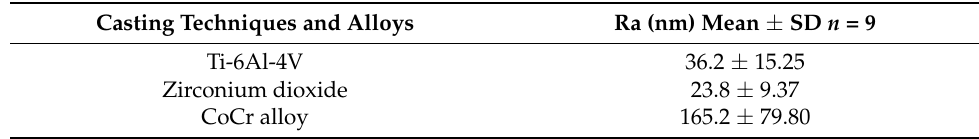
Table 2. Surface roughness (Ra) of the tested biomaterials. Casting Techniques and Alloys